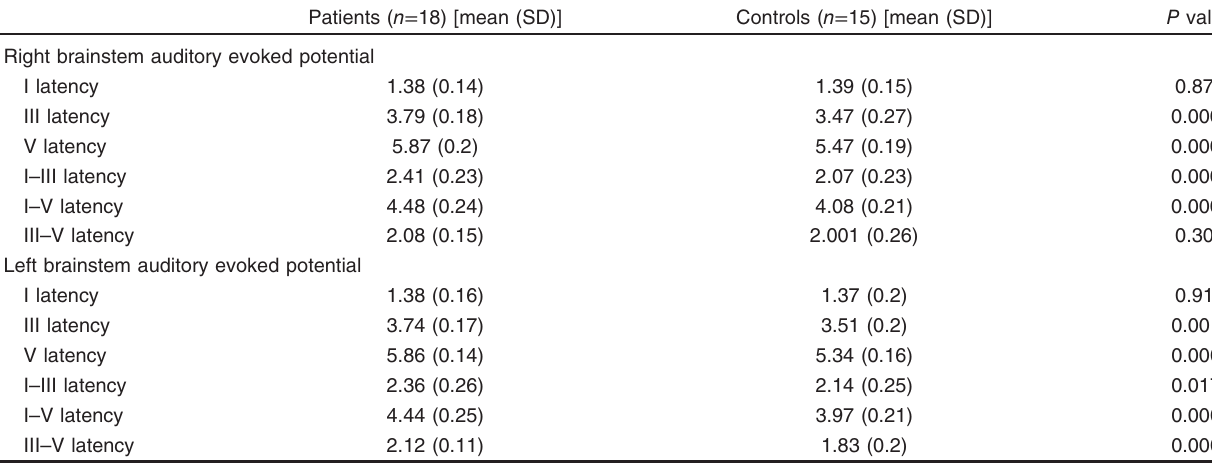
Table 2 Brainstem evoked potential results in Parkinson disease group and control group Patients ( n = 18) [mean (SD)]